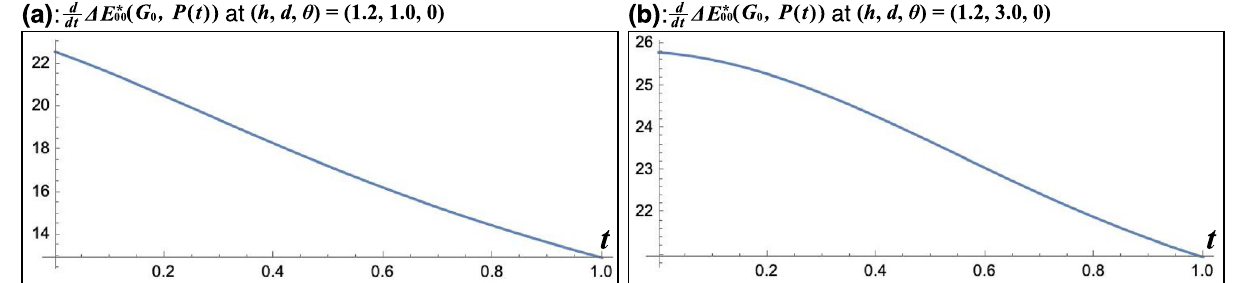
d E ∗ G P ( t )) . ( a , b ) � E ∗ 0 , dt � 00 (